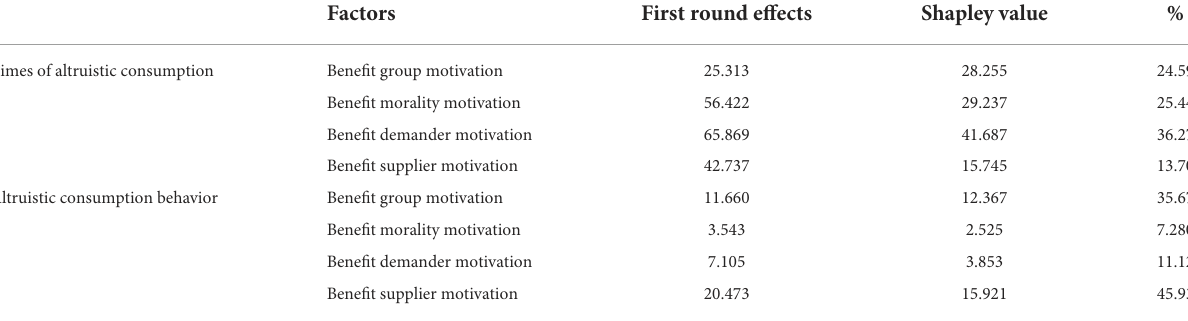
TABLE 6 Shapley value